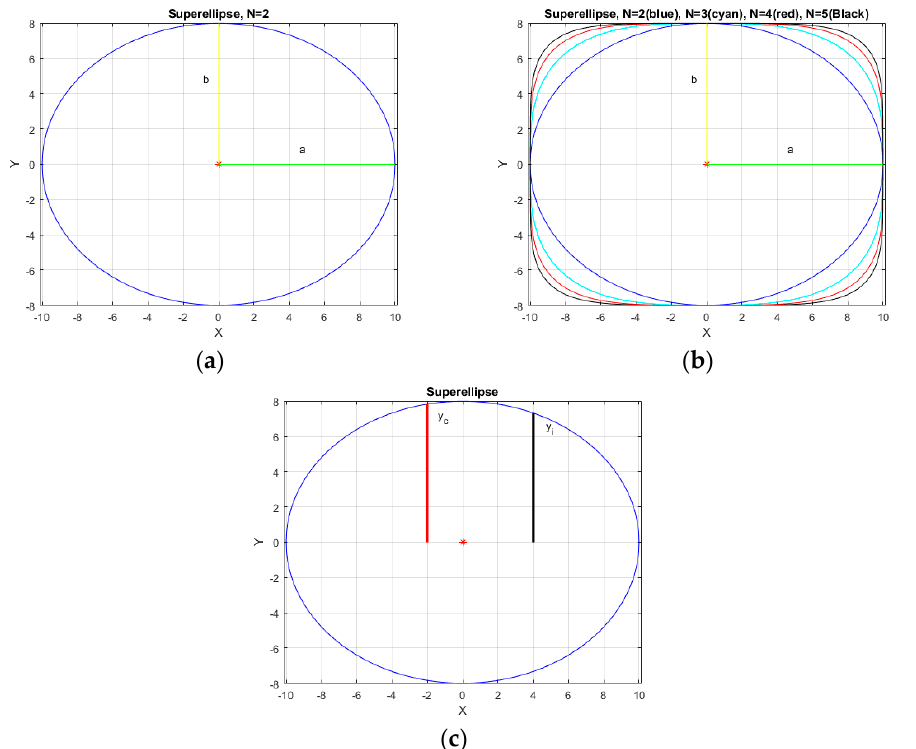
Figure 2. Superellipse with ( a ) N = 2 ( b ) N = 2 (blue), 3 (cyan), 4 (red), 5 (black). The curve is changed to more cuboidal when N increases. ( c ) The superellipse modification in our 3D reconstruction model.